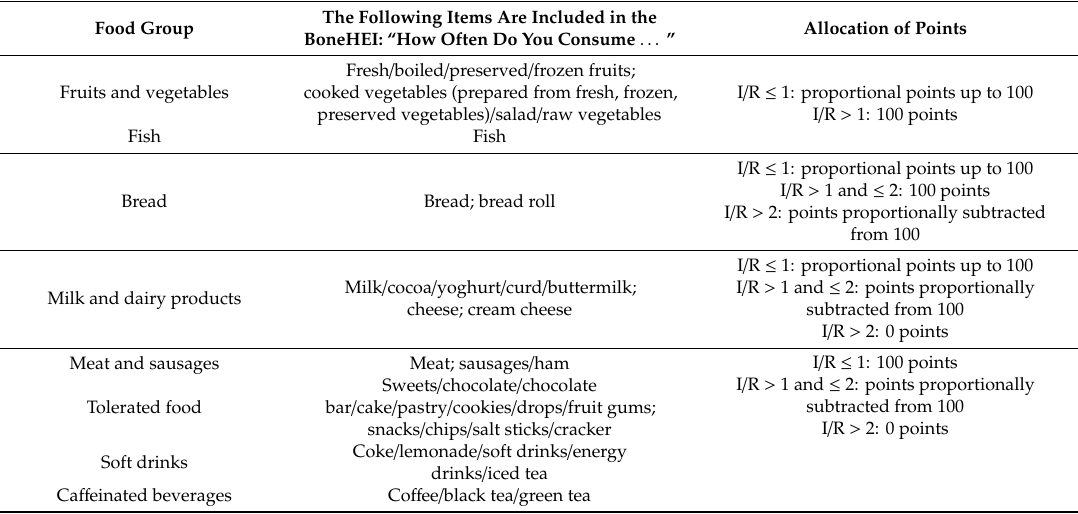
Table 1. Components and assessment of the Bone Healthy Eating Index